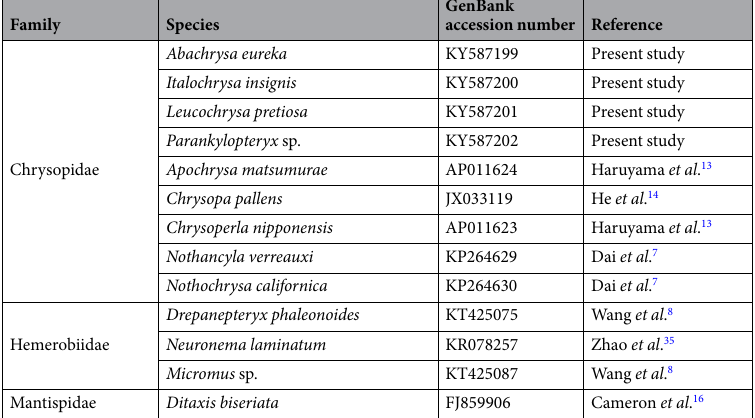
Estimations using fossil calibrations Node